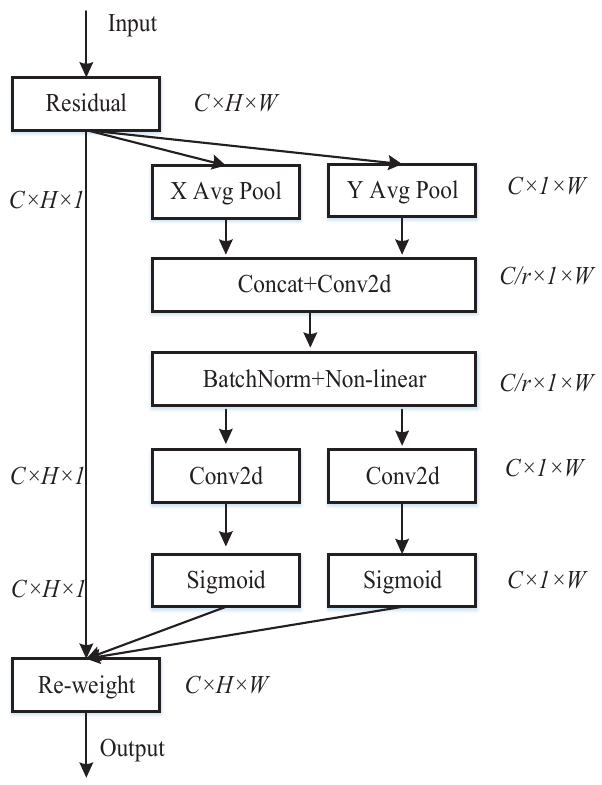
Figure 3. CA module